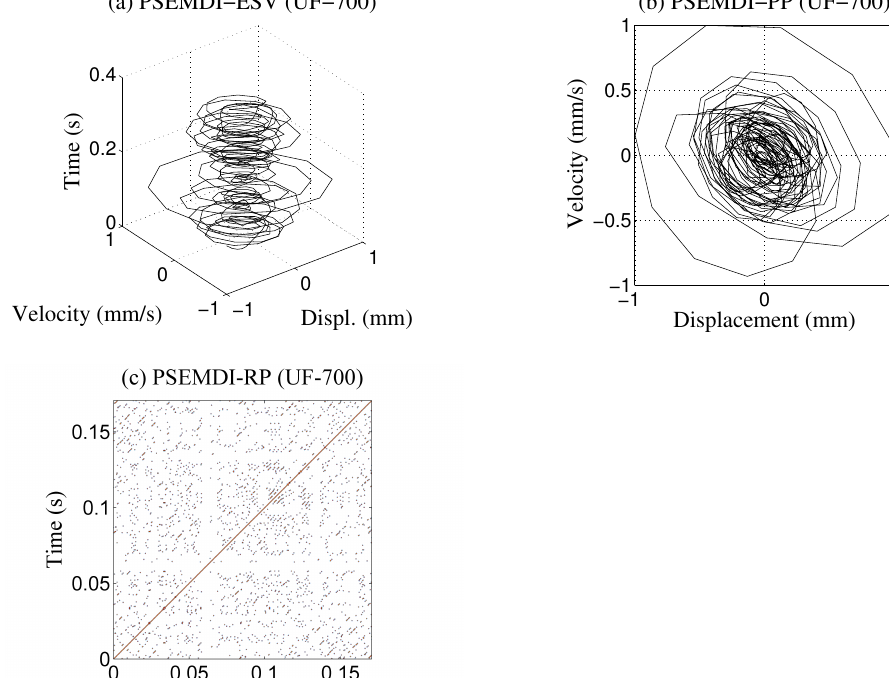
Figure 16. ( a ) Evolution of state variables; ( b ) phase plane; ( c ) recurrence plot for Case 2 at 700